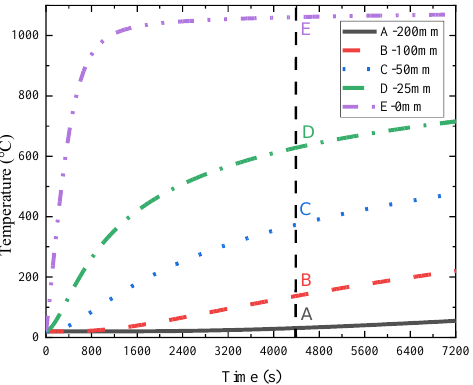
Figure 10. Temperature – time curves of concrete of various components of the model.